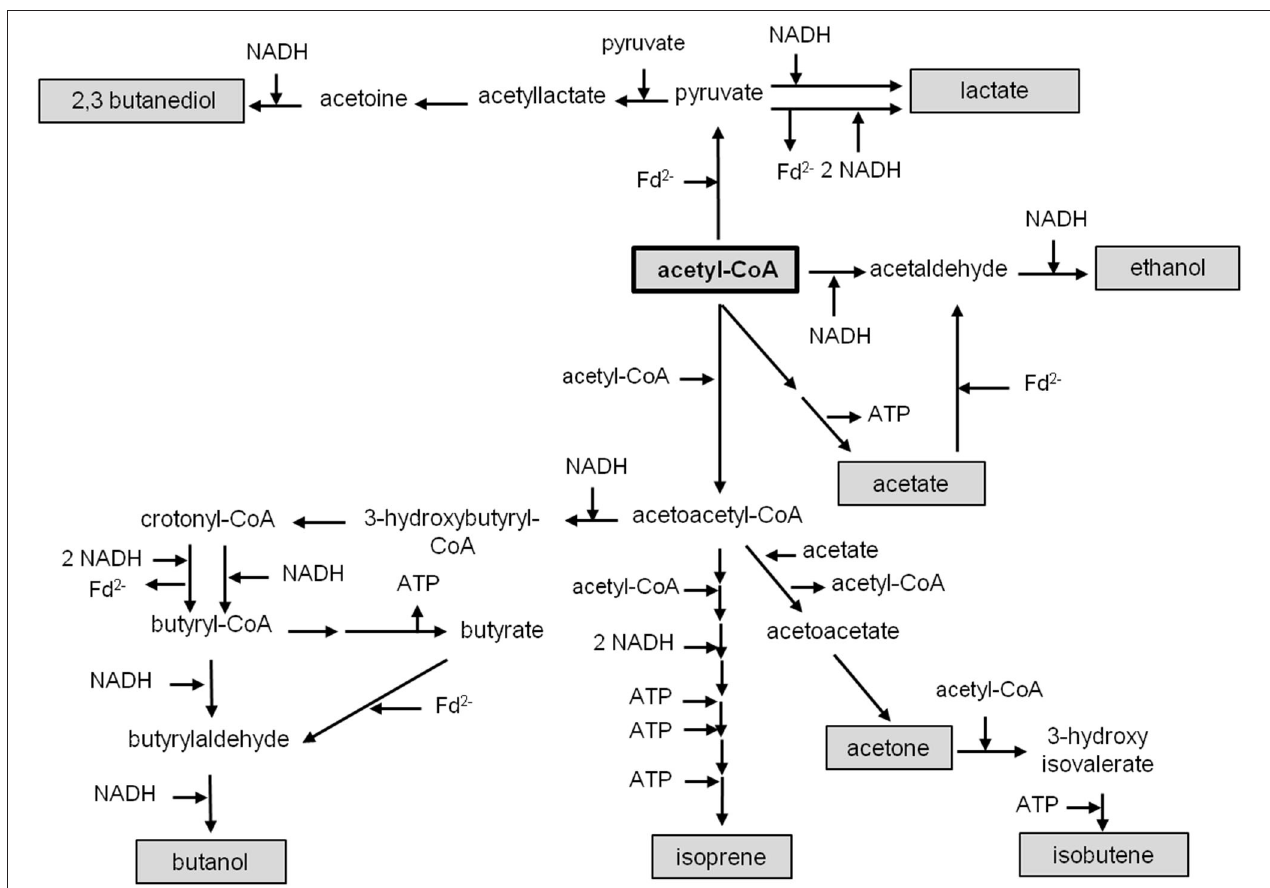
FIGURE 6 | Metabolic pathways of acetyl-CoA reduction. Acetyl-CoA is synthesized via the Wood–Ljungdahl pathway and can be converted to lactate, 2,3 butanediol, ethanol, acetate, butanol, isoprene, acetone or isobutene. Cofactors involved in different metabolic pathways are